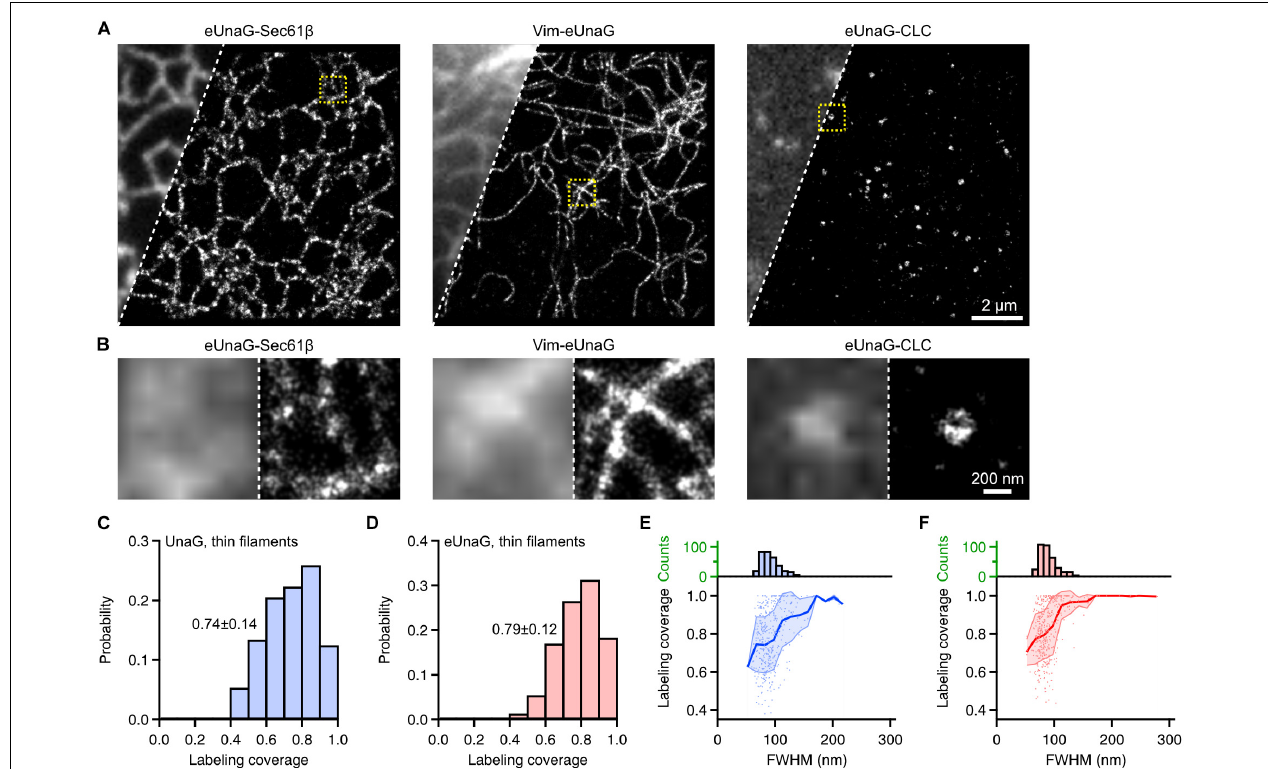
FIGURE 4 | Single-molecule localization microscopy of eUnaG-labeled subcellular structures in fixed Cos-7 cells. (A) Widefield (left) and SMLM (right) images of Cos-7 cells transfected with eUnaG-Sec61 β , Vim-eUnaG, and eUnaG-CLC. (B) Zoom-in images from yellow-dotted boxes in (A) . Each panel contains widefield (left) and SMLM (right) images. (C,D) Sampling coverage of thin vimentin filaments fused with (C) UnaG and (D) eUnaG, obtained from corresponding SMLM images. n = 102 and 180 filaments for UnaG and eUnaG, respectively. Displayed values: Mean ± SD. (E,F) Correlation between FWHM of vimentin filament and the sampling coverage for (E) UnaG- and (F) eUnaG-labeled vimentin filaments, with corresponding distribution of FWHM (upper histograms); 153 and 222 filaments were analyzed for UnaG and eUnaG, respectively. Shaded error regions indicate SDs at each